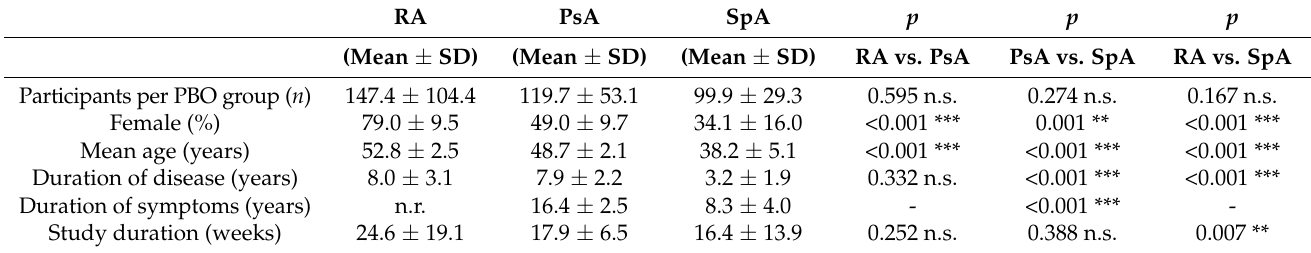
Table 1. Comparison of characteristics of participants in placebo (PBO) groups and duration of studies conducted in rheumatoid arthritis (RA), psoriatic arthritis (PsA), and spondyloarthritis